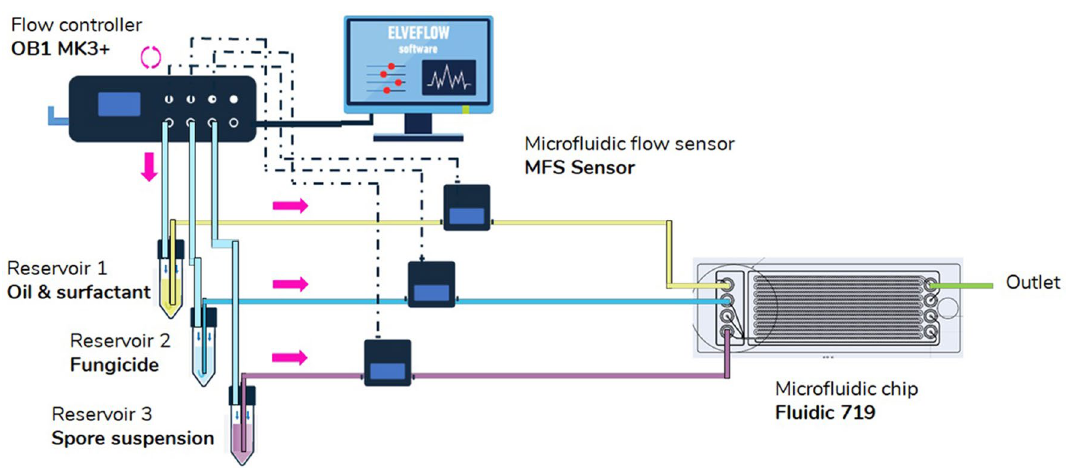
Figure 6. Schematic presentation of droplet-based platform for on-chip antifungal